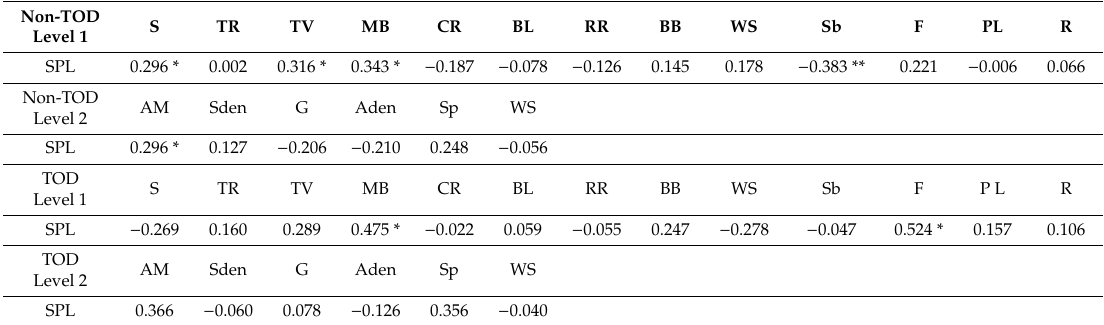
Table 4. Pearson correlation coe ffi cients between sound measurements and